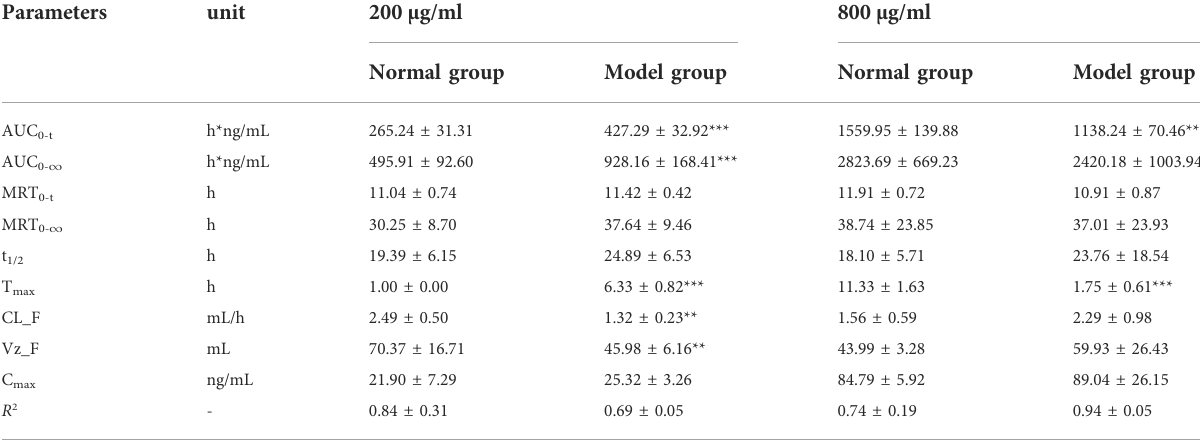
TABLE 4 The pharmacokinetic parameters of cryptochlorogenic acid in RAW264.7 cells after treatment with 200 μ g/ml and 800 μ g/ml of I. cappa extracts ( (cid:1) x ± SD, n = 6).